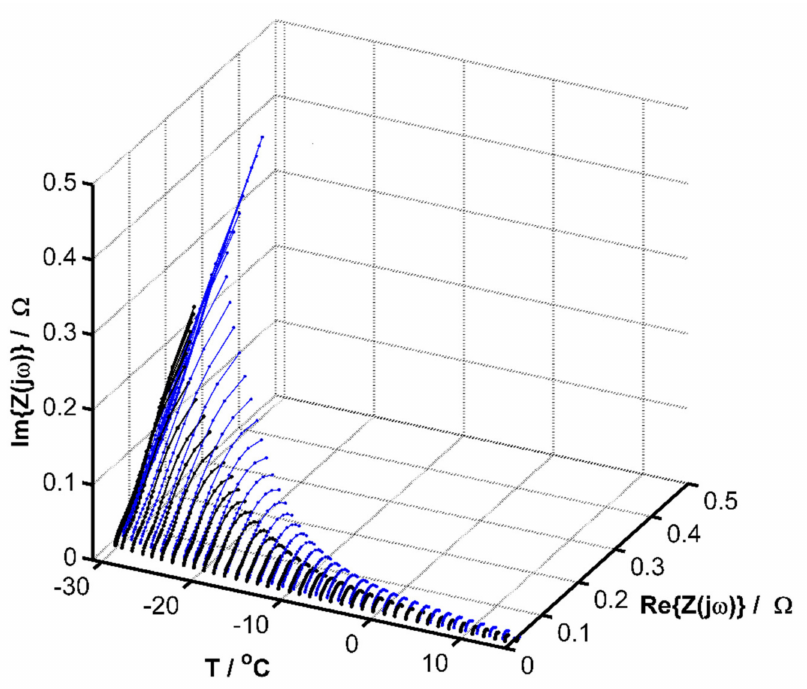
Figure 4. Comparison of impedance graphs for SoC equal to 0% (blue line) and 100% (black line) in the temperature range from − 30 to 15 degrees